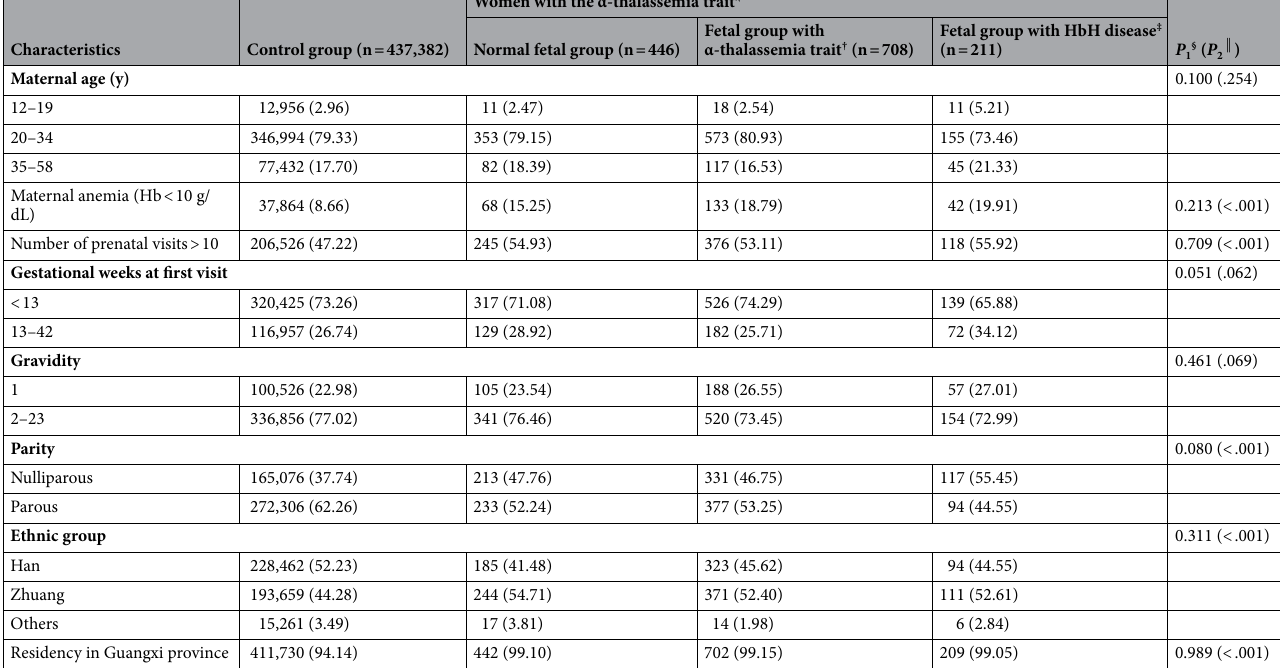
Table 1. Baseline characteristics of thalassemic women and controls. Data are n (%) unless otherwise specified. *Includes two types of heterozygous mutations, – SEA /αα (99.12%) and – THAI /αα (0.88%). † Includes two types of heterozygous mutations, – SEA /αα (98.45%) and – THAI /αα (1.55%). ‡ There were 184 deletional HbH diseases (–/–α) and 27 non-deletional HbH diseases (–/α T α). Deletional HbH diseases comprised – SEA /–α 3.7 (64.67%) and – SEA /–α 4.2 (35.33%), while non-deletional HbH diseases comprised – SEA /α CS α (92.59%) and – SEA / α QS α (7.41%). § Chi-squared test for three subgroups. ║ Chi-squared test for all